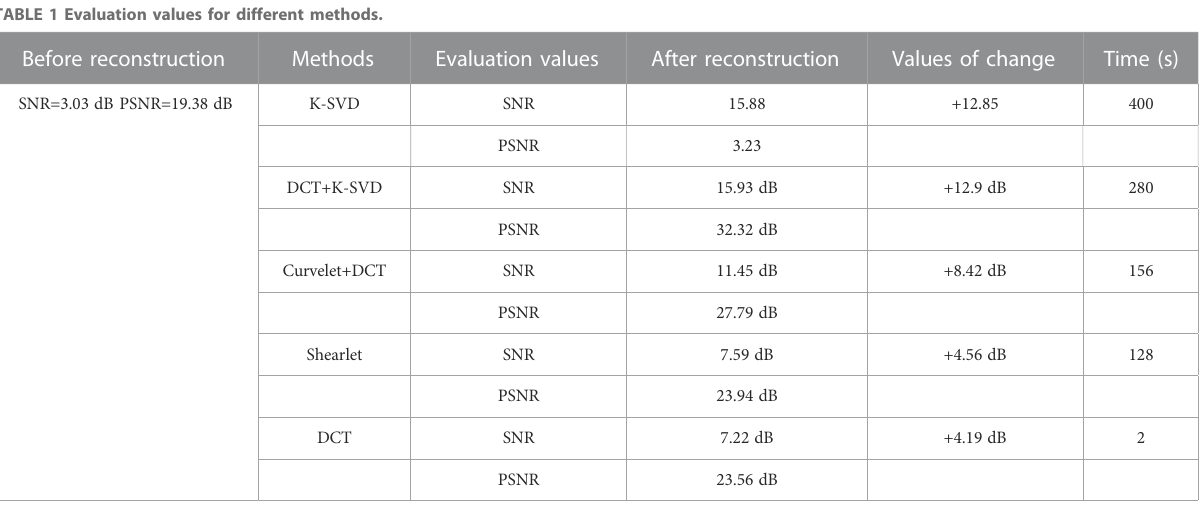
TABLE 1 Evaluation values for different methods. Before reconstruction